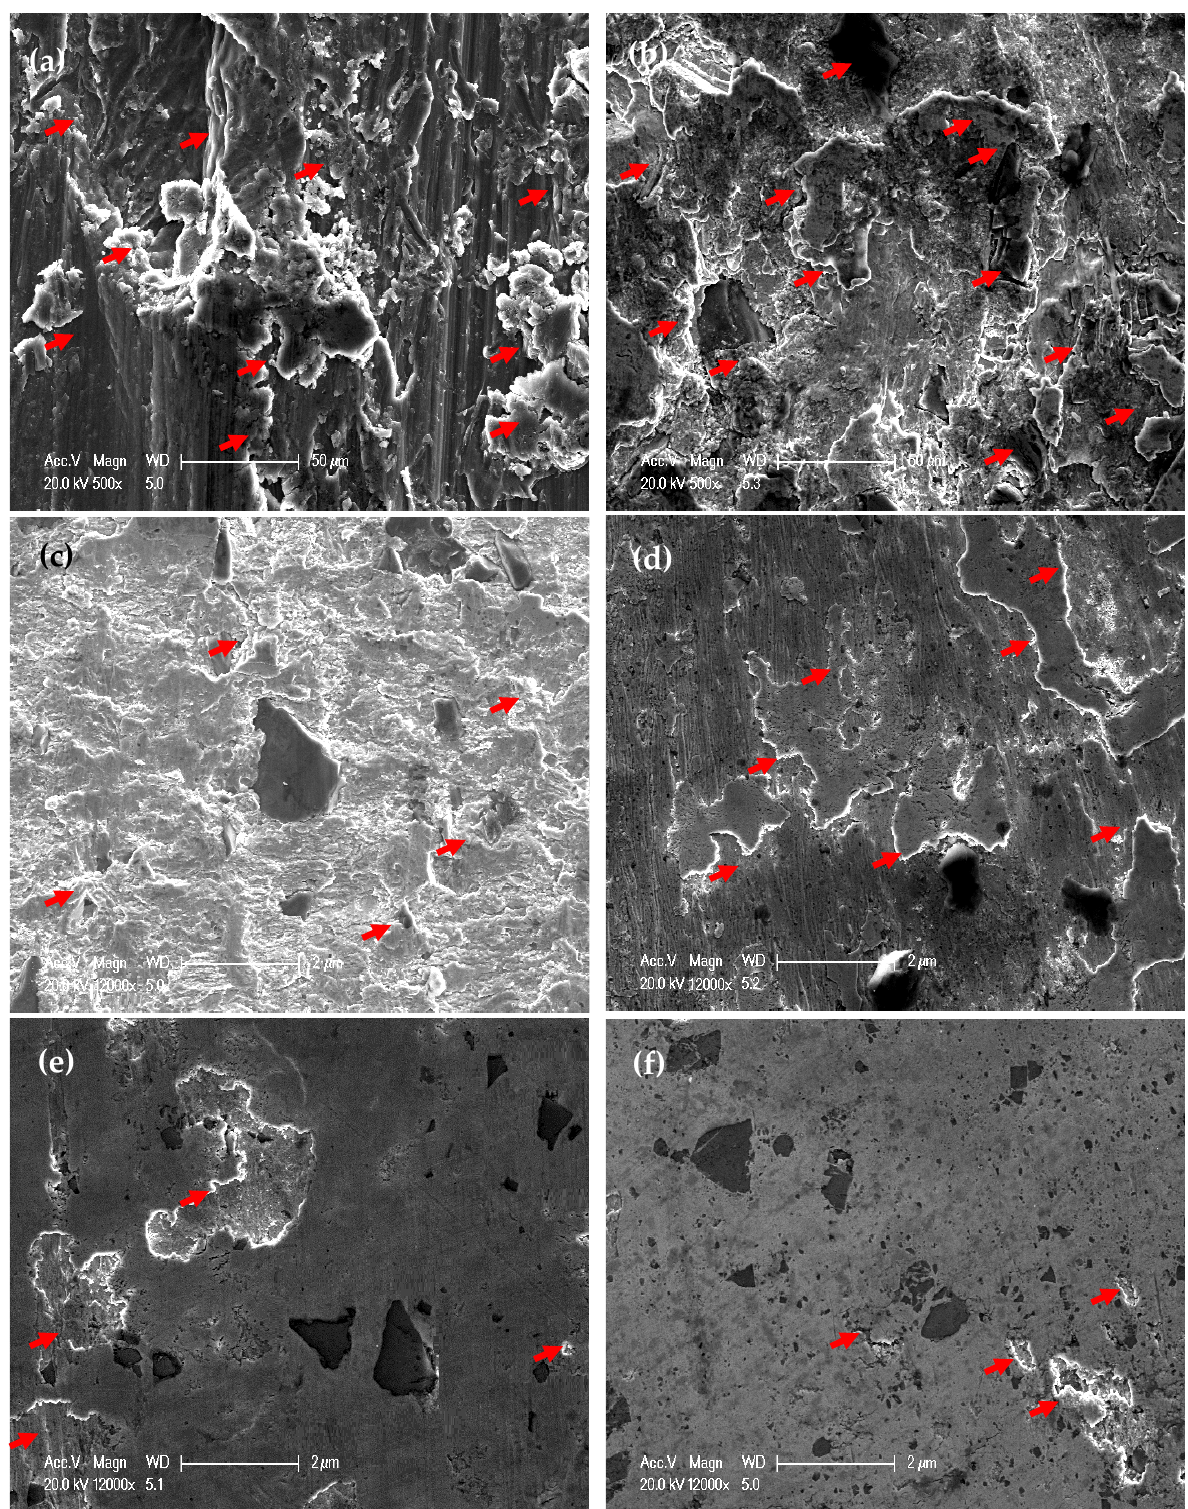
Figure 13. Worn surface morphology of ( a ) PM Al-20% Al 2 O 3 , ( b ) PM Al-20% SiC, ( c ) HPT-processed Al-10% Al 2 O 3 , ( d ) HPT-processed Al-10% SiC, ( e ) HPT-processed Al-20% Al 2 O 3 , and ( f ) HPT- processed Al-20% SiC samples obtained under an applied load of 20 N and a sliding distance of 315